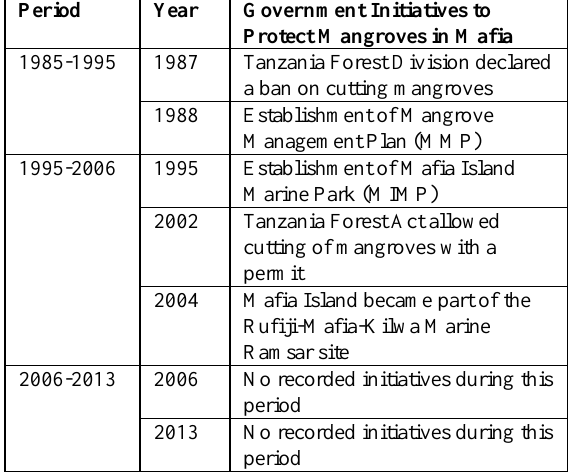
Table 1. Summary of government initiatives to protect mangroves in Mafia Island